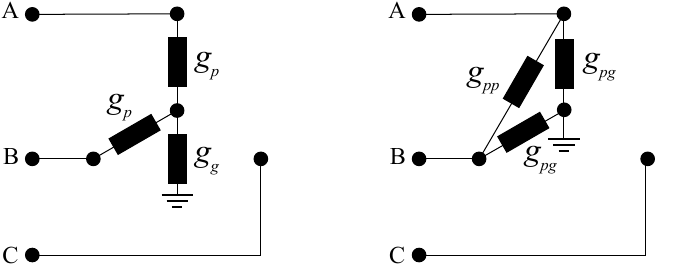
Figure 2. Star-mesh transformation for a line-line-ground fault.